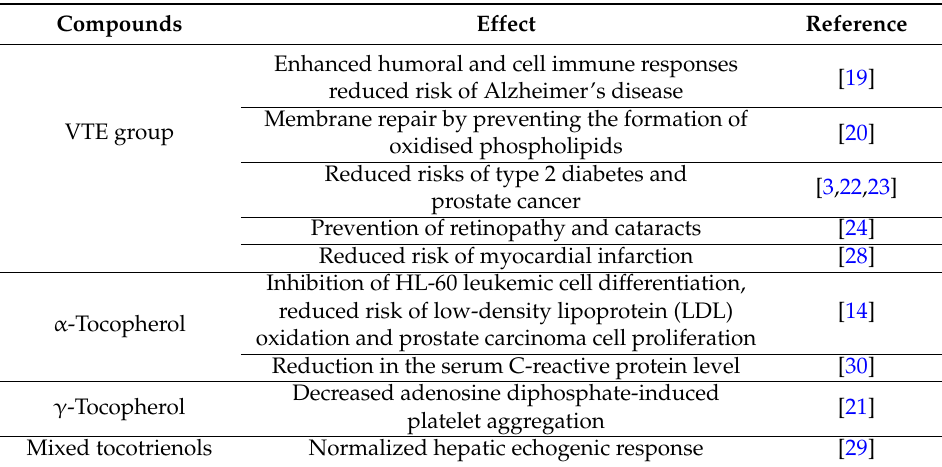
Table 1. Main mechanisms of action and functional roles of vitamin